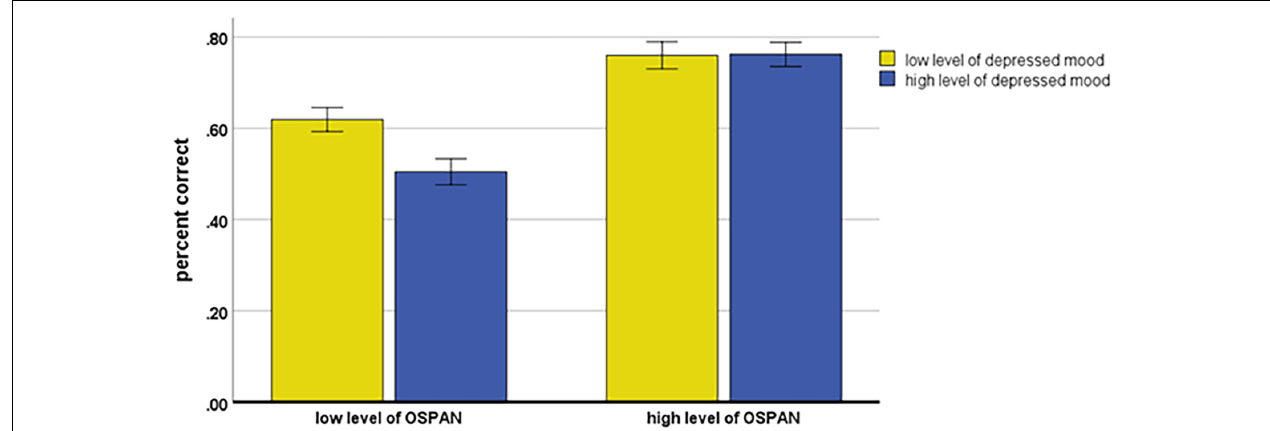
FIGURE 2 | Accuracy of syllogistic reasoning as the function of Depressed mood and OSPAN. Error bars represent the standard errors of the mean.